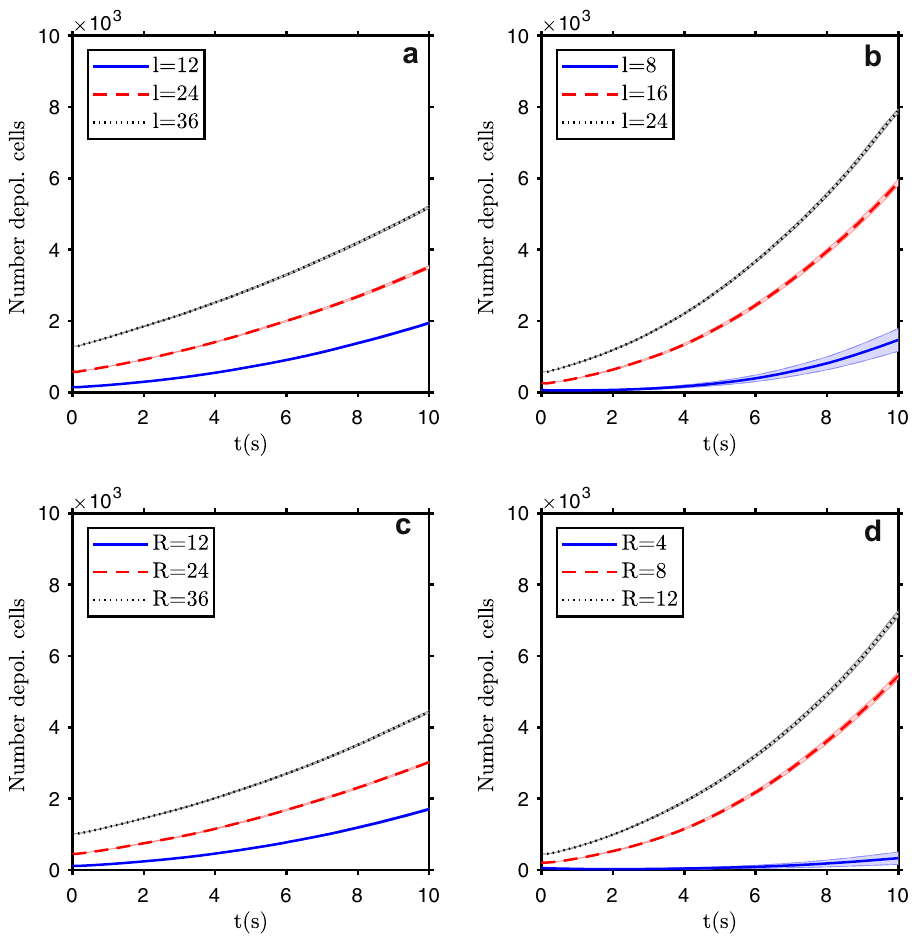
Figure 3. Tissue depolarization after the introduction of a patch of depolarized cells on a polarized tissue. Top row: evolution of the number of depolarized cells for different sizes of a square patch, introduced on the top left corner of the domain, with a width of 12, 24, and 36 cells (a) , and on the domain center, with a width of 8, 16, and 24 cells (b) . Bottom row: evolution of the number of depolarized cells for different sizes of a circular patch, with a radius of 12, 24, and 36 cells, centered on the top left corner of the domain (c) , and placed on the domain center, with a radius of 4, 8 and 12 cells (d) . The bands show the standard deviation of the mean of n = 20 simulation runs.